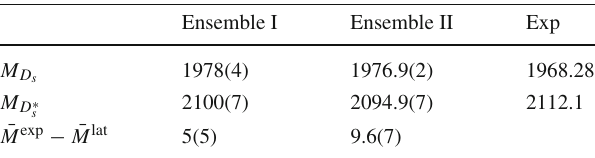
Table 2 LQCD masses (in MeV units) of the 0 − and 1 − D ( ∗ ) s mesons used in this work. They have been obtained from Tables III, VII and Fig. 13 of Ref. [38] [we always use the results corresponding to the highest volume ( L / a = 64); see discussion in the text for